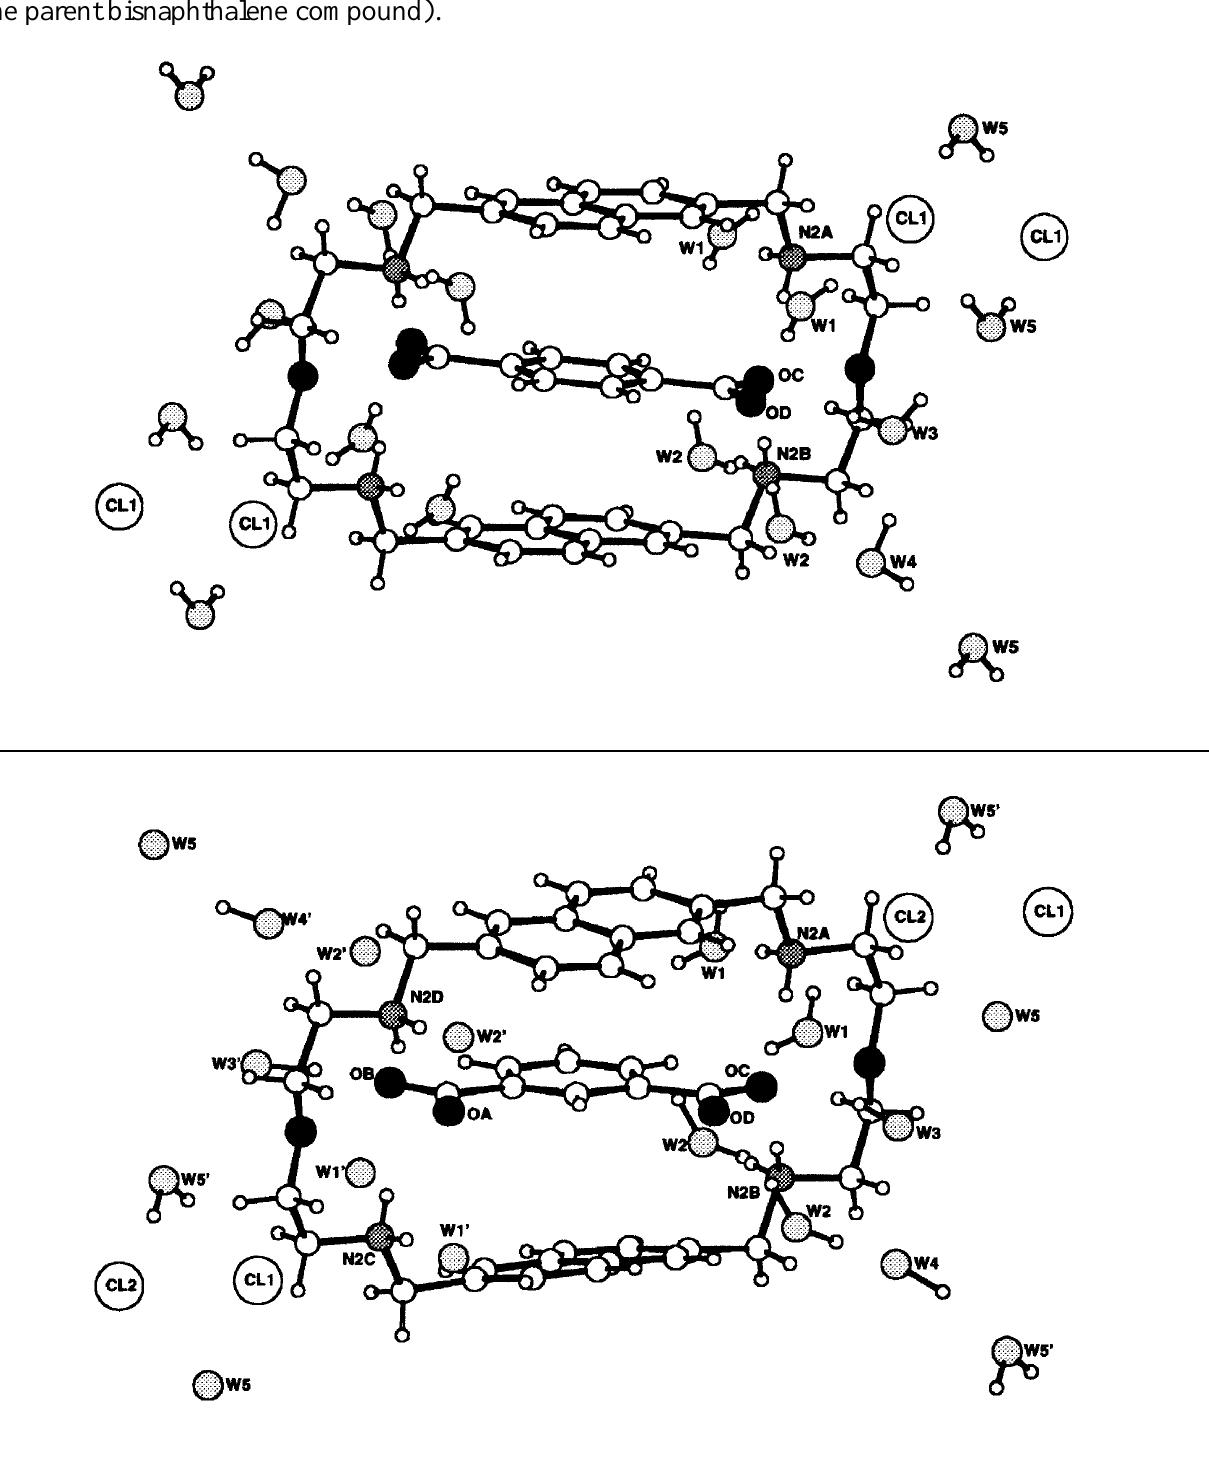
Figure 5. Crystal structures of supramolecular inclusion complexes of terephthalate and isophthalate dianions with a naphthalenic cyclobisintercaland